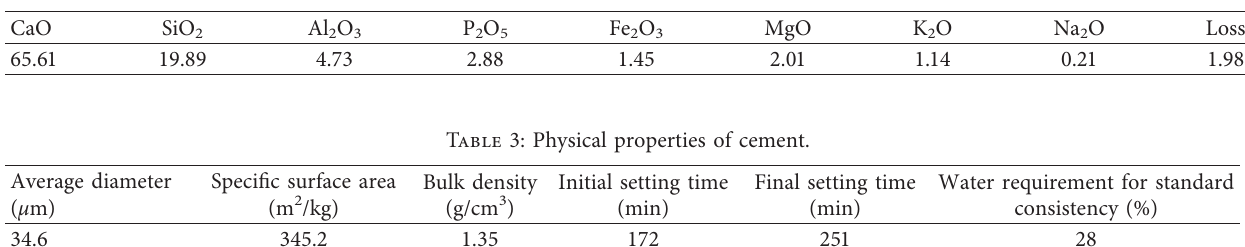
Table 2: Chemical composition of cement (%).